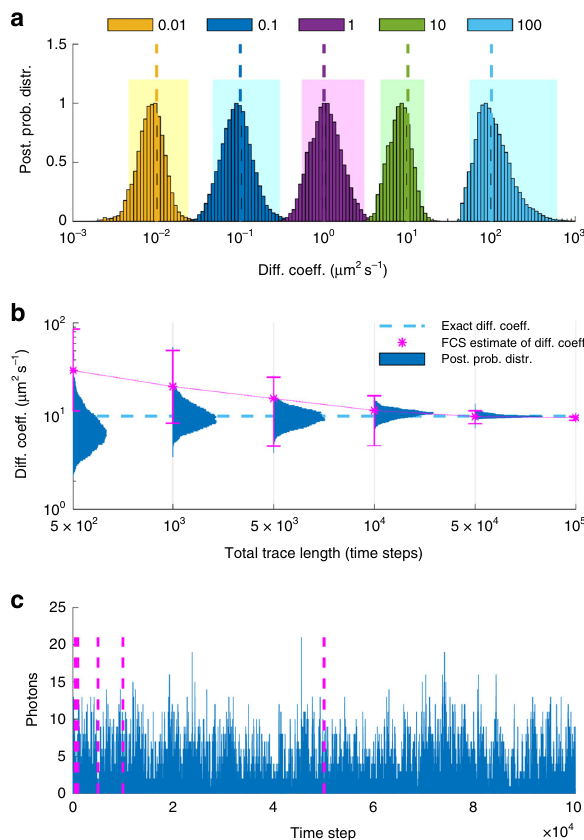
Fig. 2 Effects of diffusion coef fi cient and trace length. a Posterior probability distributions deduced from traces produced from molecules with diffusion coef fi cients of 0.01, 0.1, 1, 10, and 100 μ m 2 s − 1 . For clarity, posteriors are normalized to maximum 1 and the horizontal axis is shown in logarithmic scale. Shaded regions illustrate the 95% con fi dence intervals. b Posterior probability distributions deduced from traces acquired at 100 μ s with total trace lengths of 5 × 10 2 , 1 × 10 3 , 5 × 10 3 , 1 × 10 4 , 5 × 10 4 time steps. For the sake of comparison, exact values and FCS estimates are also shown and, for clarity, the vertical axis is shown in logarithmic scale. Error bars in the FCS curve are produced by analyzing multiple windows in the initial trace. In order to estimate the diffusion coef fi cient within less than a factor of 2 of the true value, it is typical for FCS to require ≈ 50 × more data than our method. c The entire trace used to deduce diffusion coef fi cients in a , b . Each segment, marked by dashed lines, represents the portion used in b